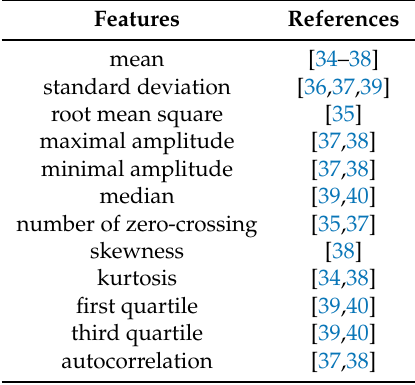
Table 10. Temporal features extracted from all wearable and ambient devices of the consolidated